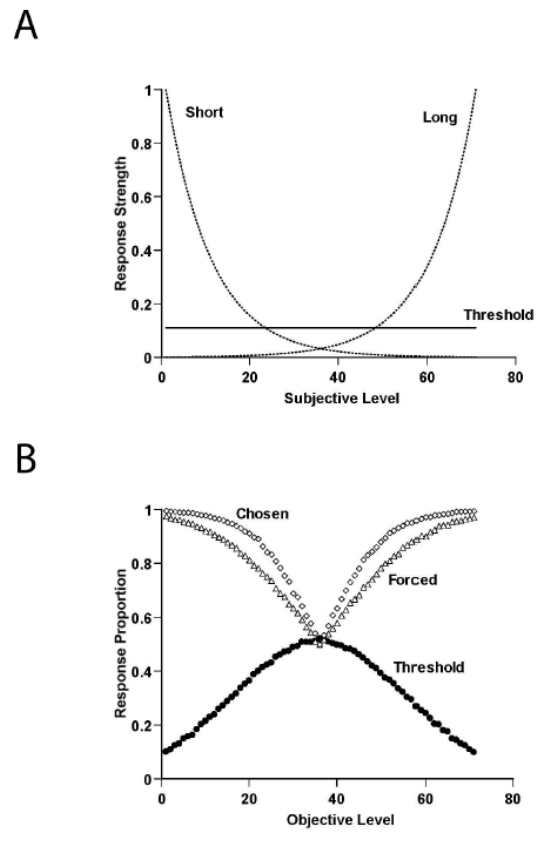
Figure 3. Schematic of Smith and colleagues’ (2008) low-level, response-strength model and simulation. A. Presentation of a stimulus gives rise to a subjective level or impression of that stimulus. Each response has a hypothetical response strength for any given subjective level. The schematic outlines response strengths for two primary responses in a two- alternative forced-choice procedure and for a third (i.e., decline or uncertainty) response (labeled threshold). Note that response strength is constant for the third response (i.e., it is stimulus independent). By contrast, response strength is highest for the easiest problems (i.e., the extreme subjective levels). Note also that the decline-response strength is higher than the other response strengths for the most difficult problems (i.e., middle subjective levels). Note that Smith and colleagues’ (2008) specifically metacognition model. Reproduced from Smith et al. (2008). B. Simulation of schematic shown in A. Simulation of Smith